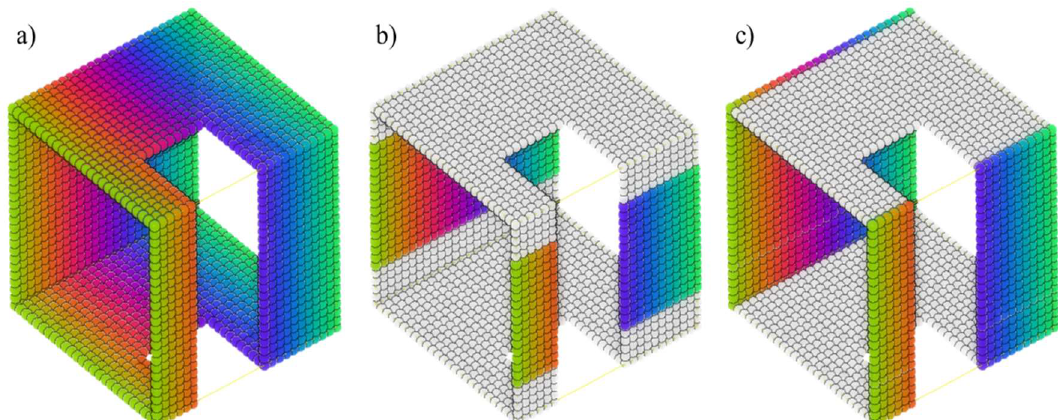
Figure 4 . Morphological opening for the segmentation of vertical points: a) Input point cloud, b) eroded point cloud) and c) dilated point cloud. Note: Input data is preserved in grey colour for improving